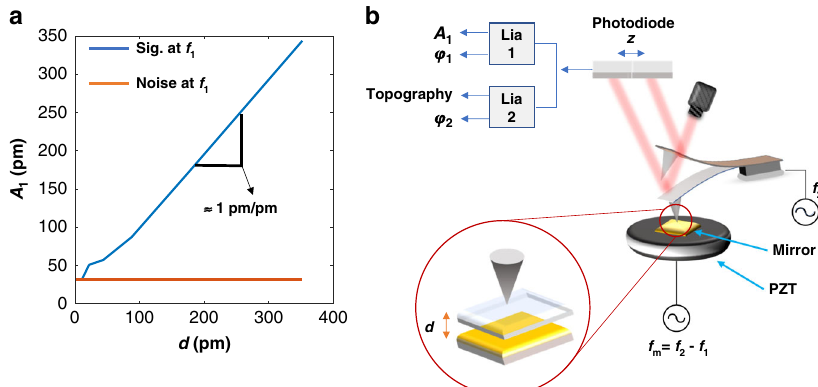
Fig. 3 Non-contact AFM sensitivity to thermal expansion. a The peak – peak oscillation amplitude (blue solid line) measured at f 1 as a function of the PZT displacement amplitude ( d ). The noise level of the system measured at f 1 corresponds to oscillation of about 32 pm peak – peak as indicated by the orange line. Tip – sample gap is controlled at f 2 and the PZT is driven at f m = f 2 − f 1 . b depicts the experimental set-up.